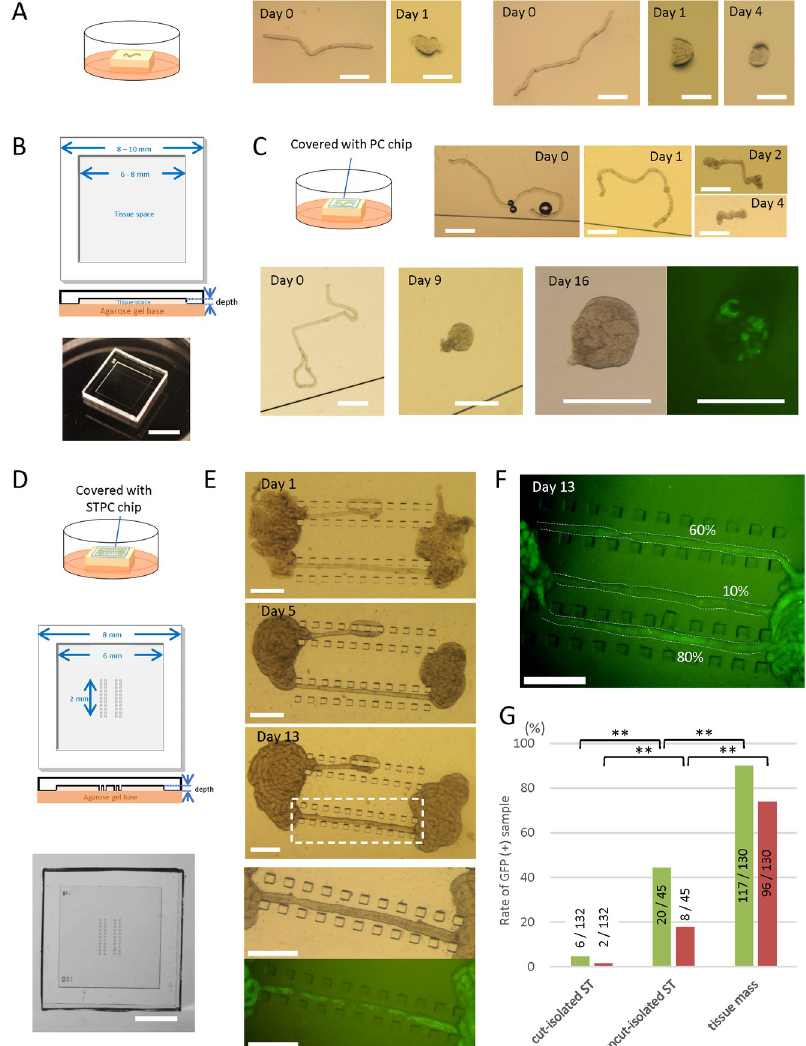
Fig 1. Culturing of isolated ST segments. (A) According to an air-liquid interphase method, cut-isolated STs of a 5 dpp mouse were placed on an agarose gel block half-soaked in the medium. The STs shrunk and conglomerated in a day. (B) Schematic diagram of a PC chip, top and cross-sectional views, and photos of a PC chip. The depth of dent for accommodating culture samples was between 150 and 190 μ m. (C) A schematic drawing of a culture experiment using a PC chip, and a stereomicroscopic view of a cut-isolated ST of a 5 dpp mouse covered with a PC chip. The ST shrunk in several days. Another cut-isolated ST cultured under a PC chip conglomerated but showed GFP expression on culture day 16. (D) A schematic drawing of a culture experiment using STPC, and a schematic diagram of a STPC chip, top and cross-sectional views. The size of each pillar was 0.1 × 0.1 mm. Four parallel pillar rows made of 11 pillars each were arranged in the center of the tissue space. The depth of the tissue space ranged from 150 to 190 μ m. A photo of an STPC chip from above is shown in the bottom pannel. (E) Stereomicroscopic view of an uncut-isolated ST cultured under an STPC chip on days 1, 5, and 13. The dashed rectangular area is enlarged in the bottom two panels. Fluorescence microscopy revealed Acr -GFP expression in the stretched portion of the ST. (F) A photo of the GFP- expressing portion of three uncut-isolated STs, taken on culture day 13. The percentages of GFP-expressing area were visually measured as 60%, 10%, and 80%, respectively. (G) The percentages of GFP-positive area in the samples of three ST states: cut-isolated STs, uncut-isolated STs, and tissue mass. Samples with GFP-expressing areas over 10% (green bar) and 50% (red bar) during culture days 31 to 40 were counted as GFP-positive. Numerators and denominators in or over each bar are the numbers of GFP-positive tissue samples and total examined tissue samples, respectively. The experiments were performed under a 20% O 2 concentration. ** P < 0.01. Scale bars: 5 mm (B), 2 mm (D), 0.5 mm (A, C, E).